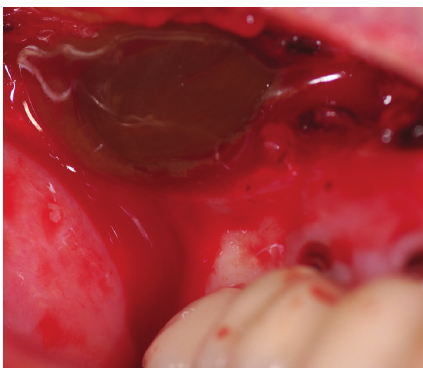
Figure 6: Intraoperative view of the right maxillary sinus: after incision and preparation of the right upper jaw, a defect of the facial bone sinus on the right side appears.